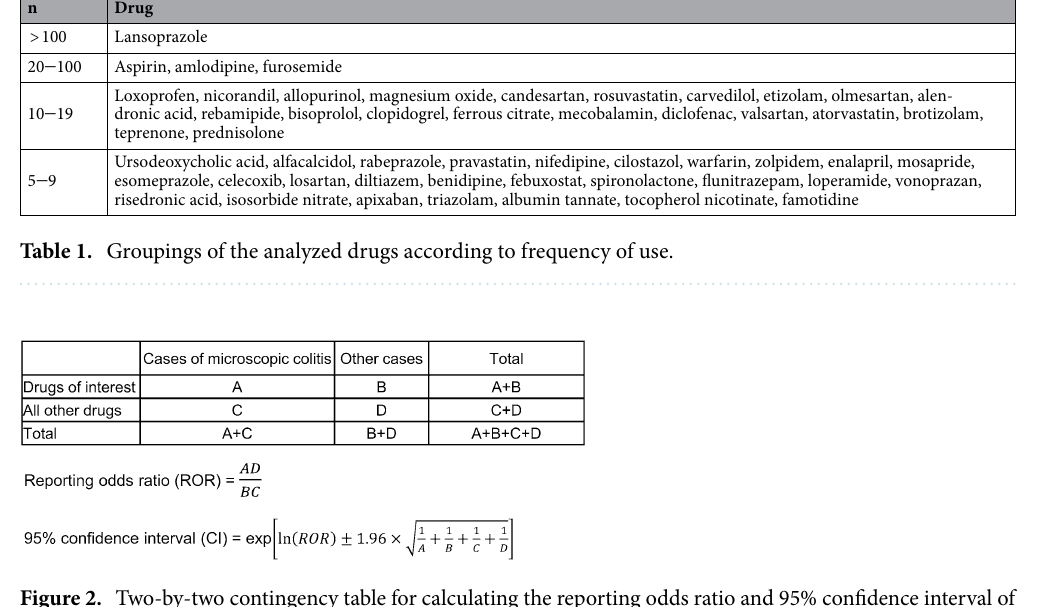
Figure 2. Two-by-two contingency table for calculating the reporting odds ratio and 95% confidence interval of microscopic